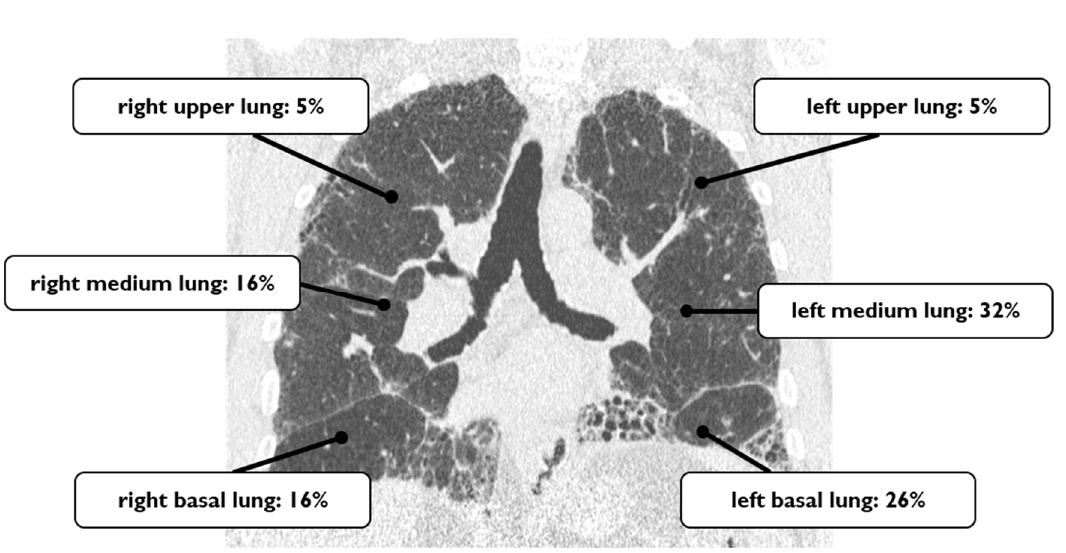
Figure 2. The coronal HRCT image shows the lung cancer distribution identified in our series.